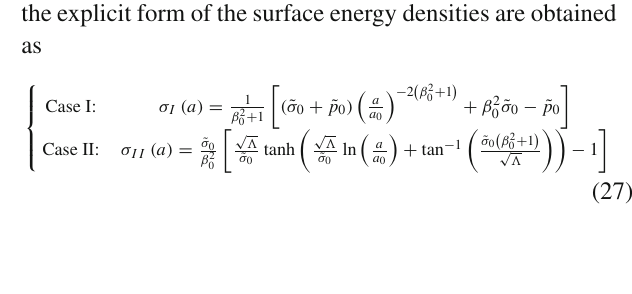
= 16, M = 1 and from above v = 0 . 0 , 0 . 2 , 0 . 4 , 0 . 6 , 0 . 8 and 1 . 0. This figure is in analogy 0 0